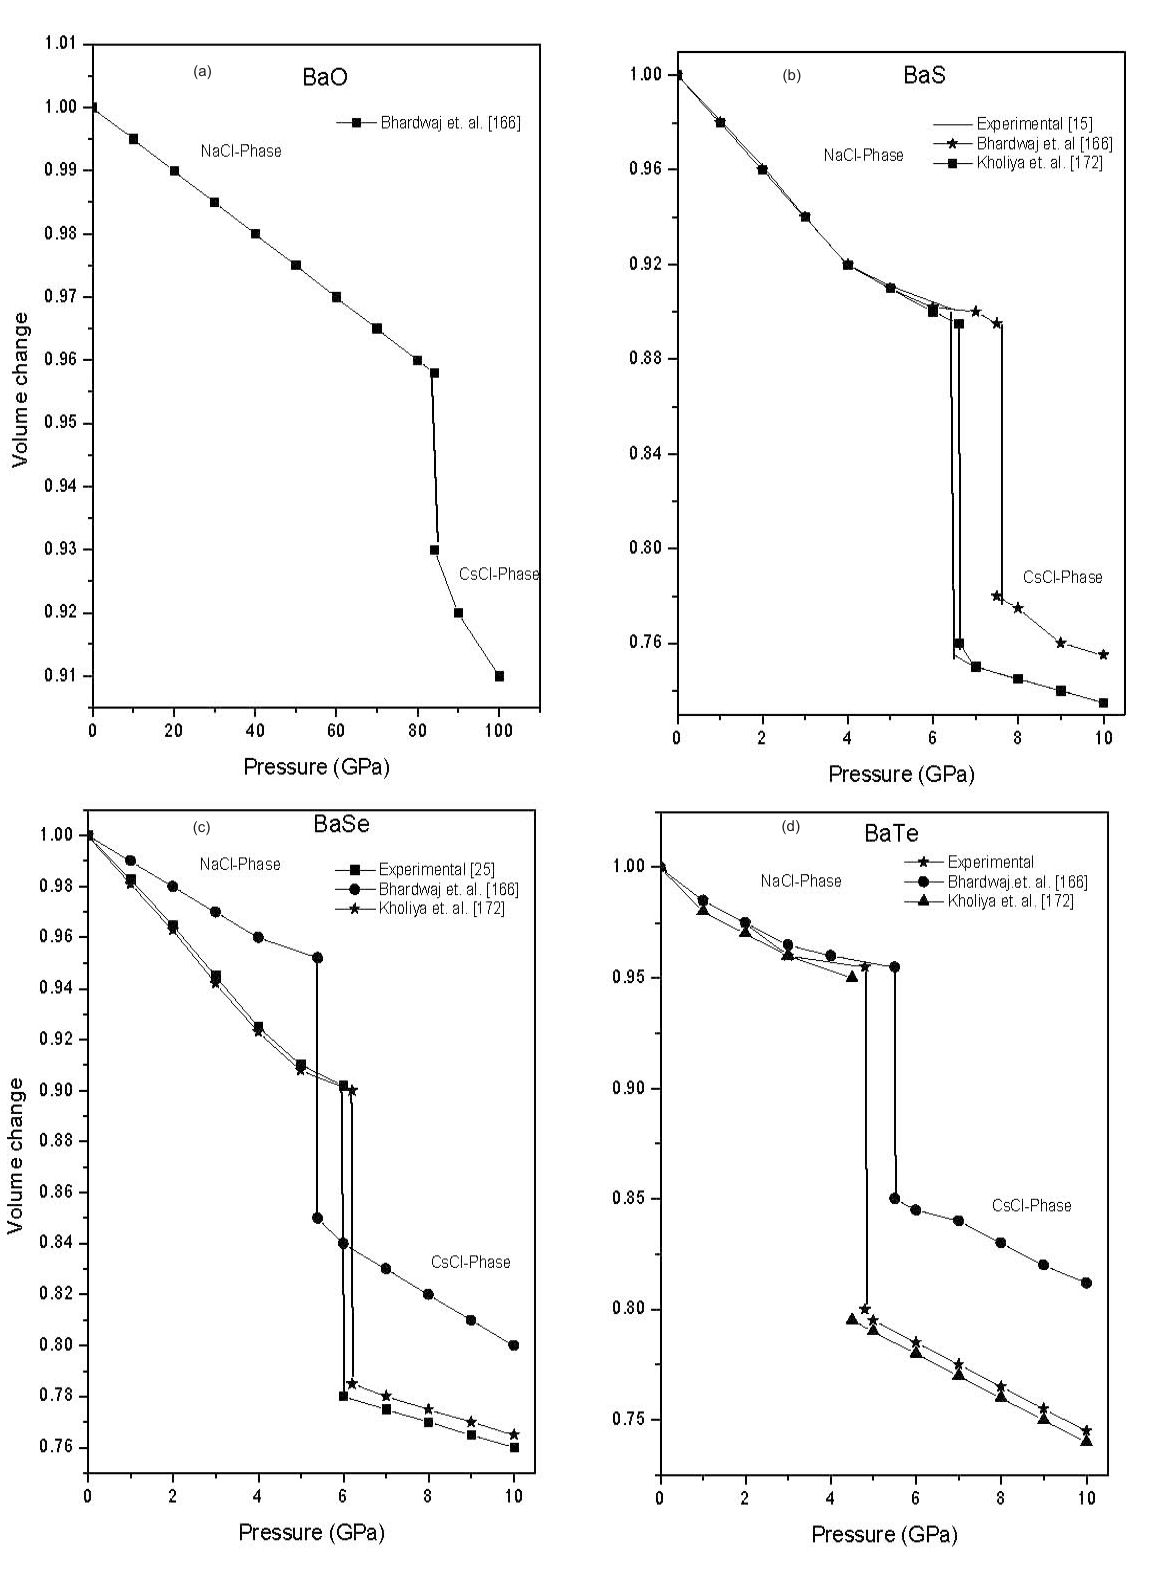
Figure 5. Variation of volume collapse with pressure for strontium